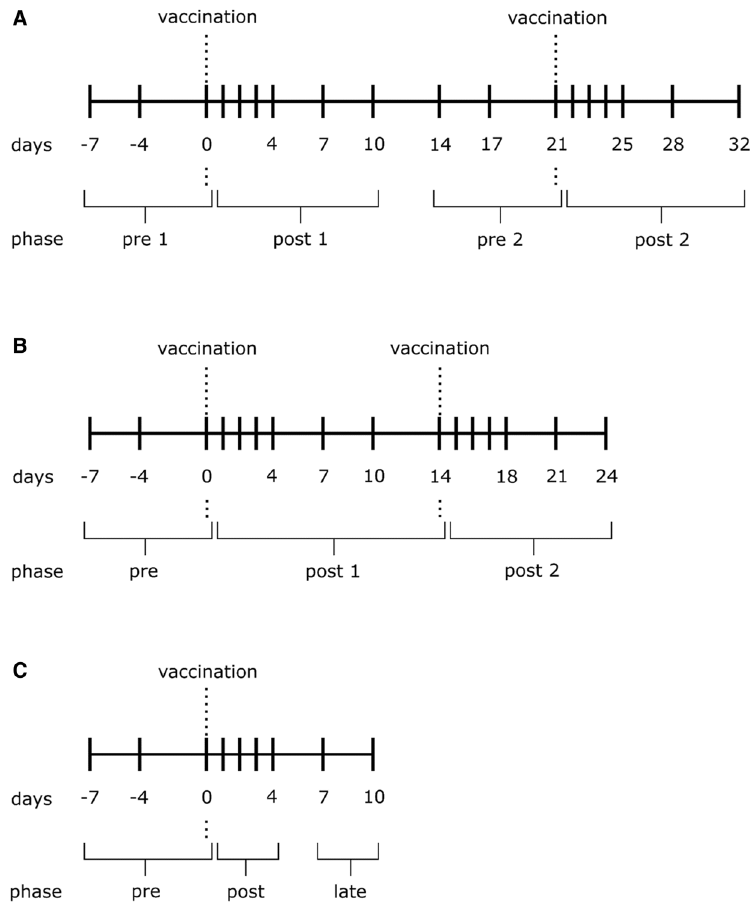
Figure 1. Sampling schemes in three different treatment groups: ( A ) (Bovalto Respi 3), ( B ) (Insol Trichophyton) and ( C ) (Bovela); n = 5